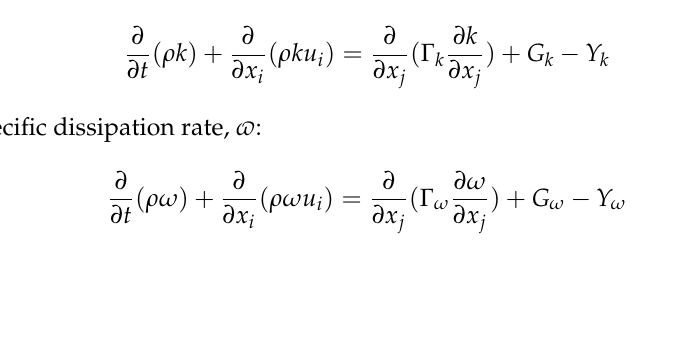
Figure 12. Distribution of wall Y+ values on the CFD model with a duct.